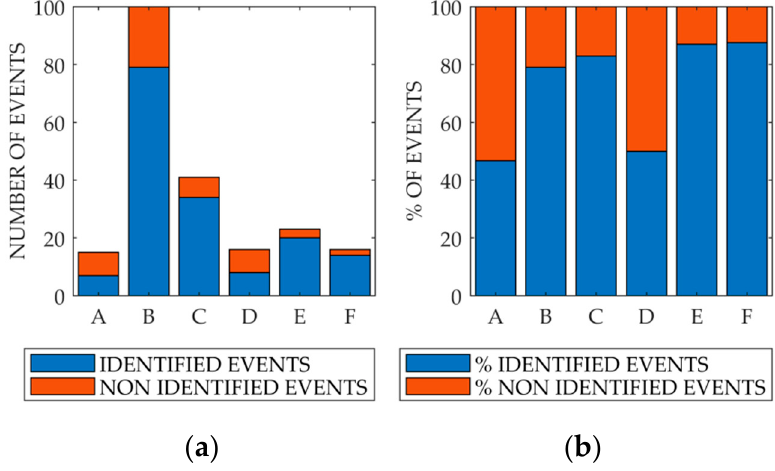
Figure 9. The ERDS performance compared to the disaster type: “A” represents “convective storms”, “B” represents “flood events”, “C” represents “hurricanes and cyclones”, “D” represents “heavy rain-induced landslides”, “E” represents “flash floods” and “F” represents “tropical storms”. ( a ) The results in terms of the number of events and ( b ) the results in terms of percentage.